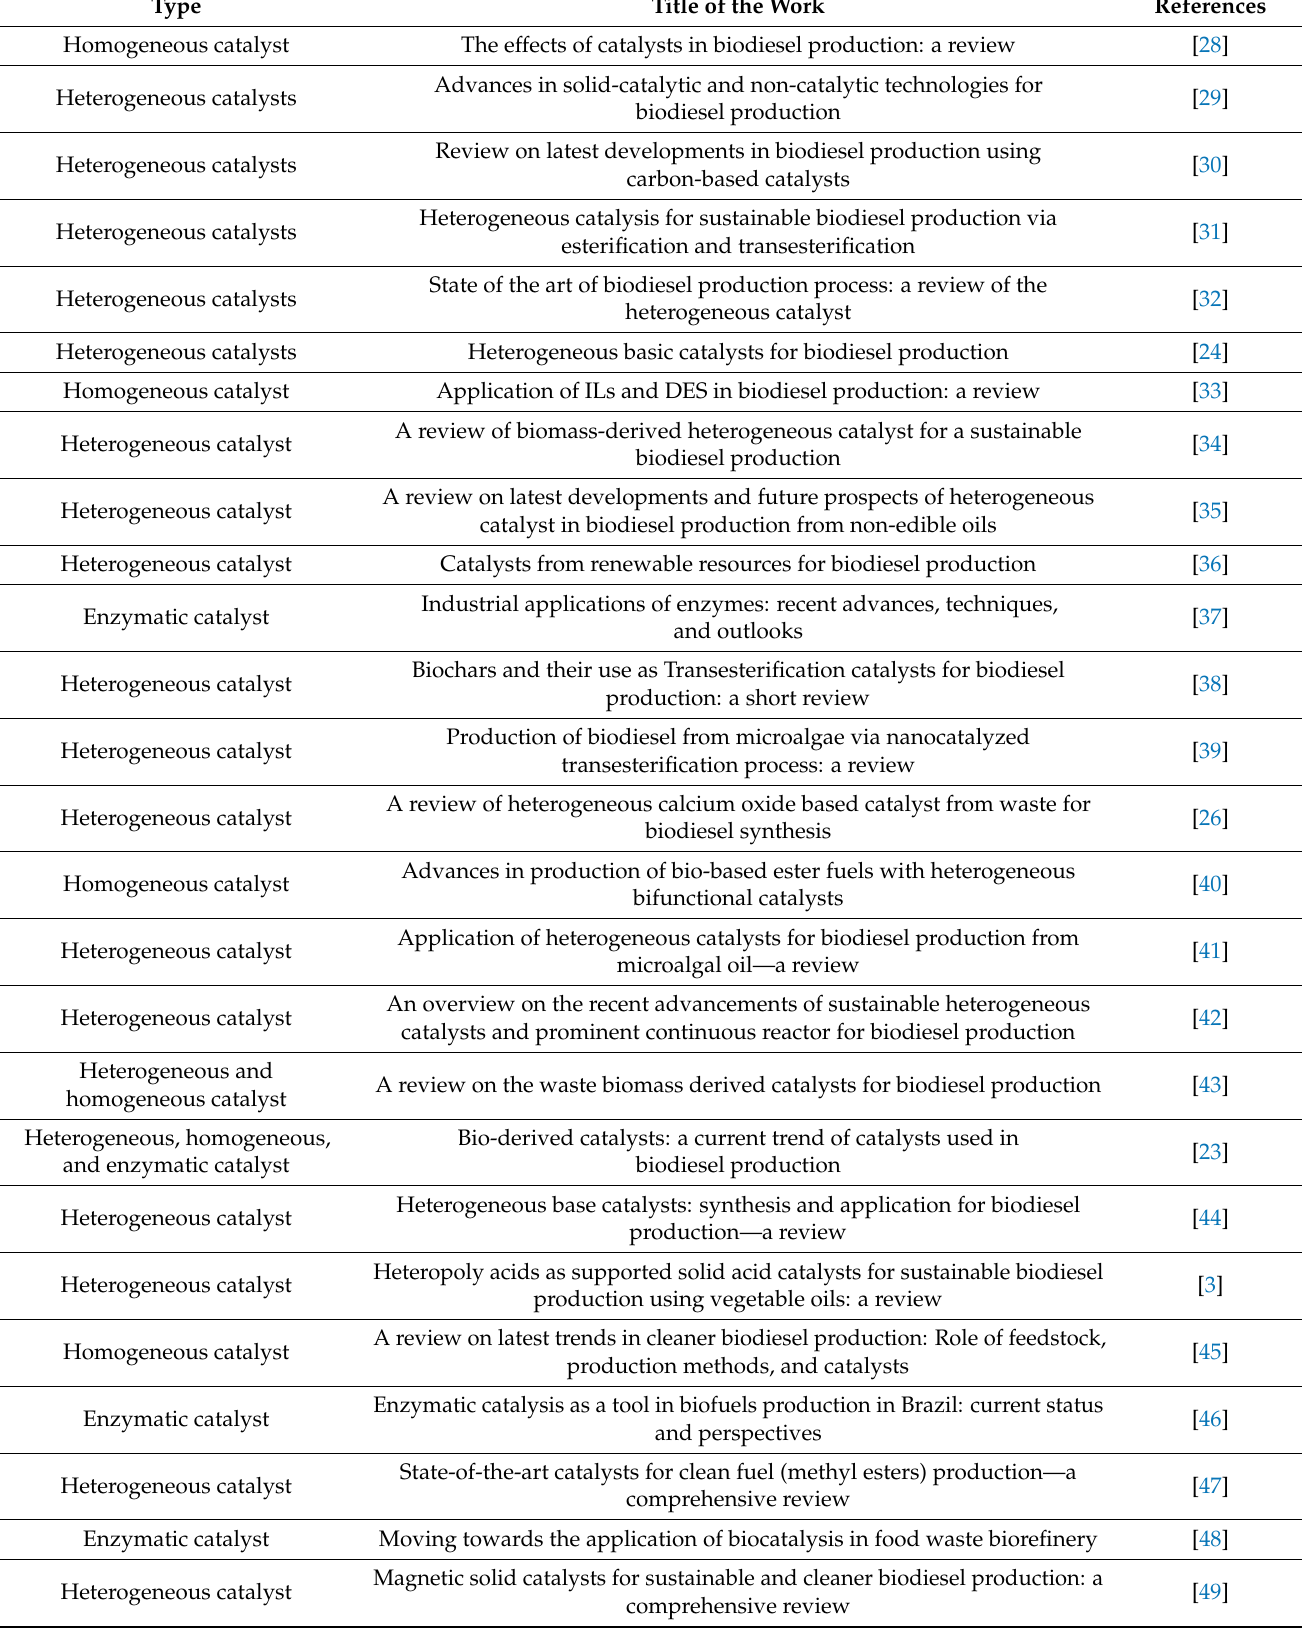
Table 1. Statistics of review articles on biodiesel catalysts in the last